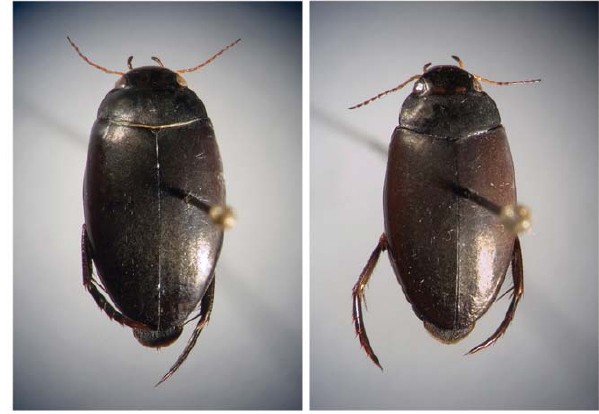
Figure 1. The two ecotypes of Agabusbipustulatus in northern Sweden: lowland (left side) and montane (right side).